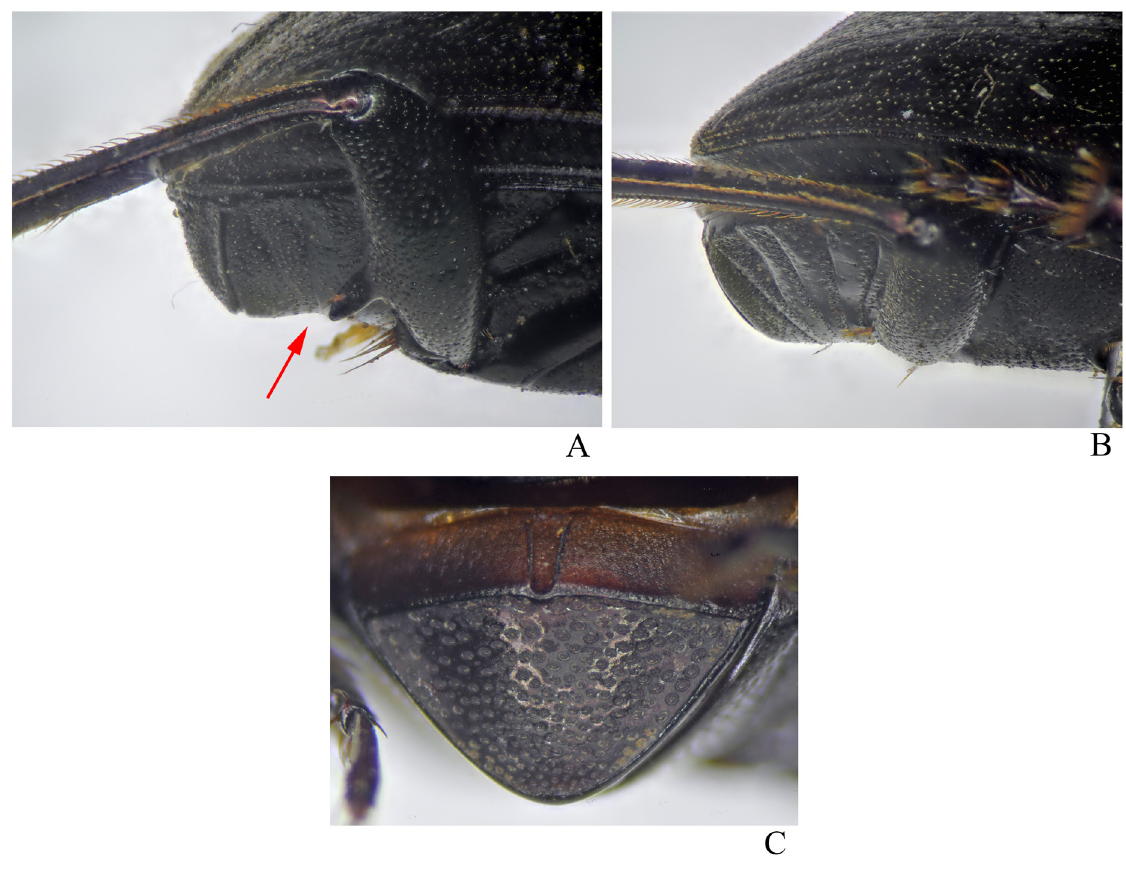
Fig. 22. Abdomen of Streblopus opatroides van Lansberge, 1874. A‒B . Lateral view. A . ♂. B . ♀. Note that the female abdomen has a straighter surface than that of the male, which is concave (red arrow shows this concavity). C . Pygidium and